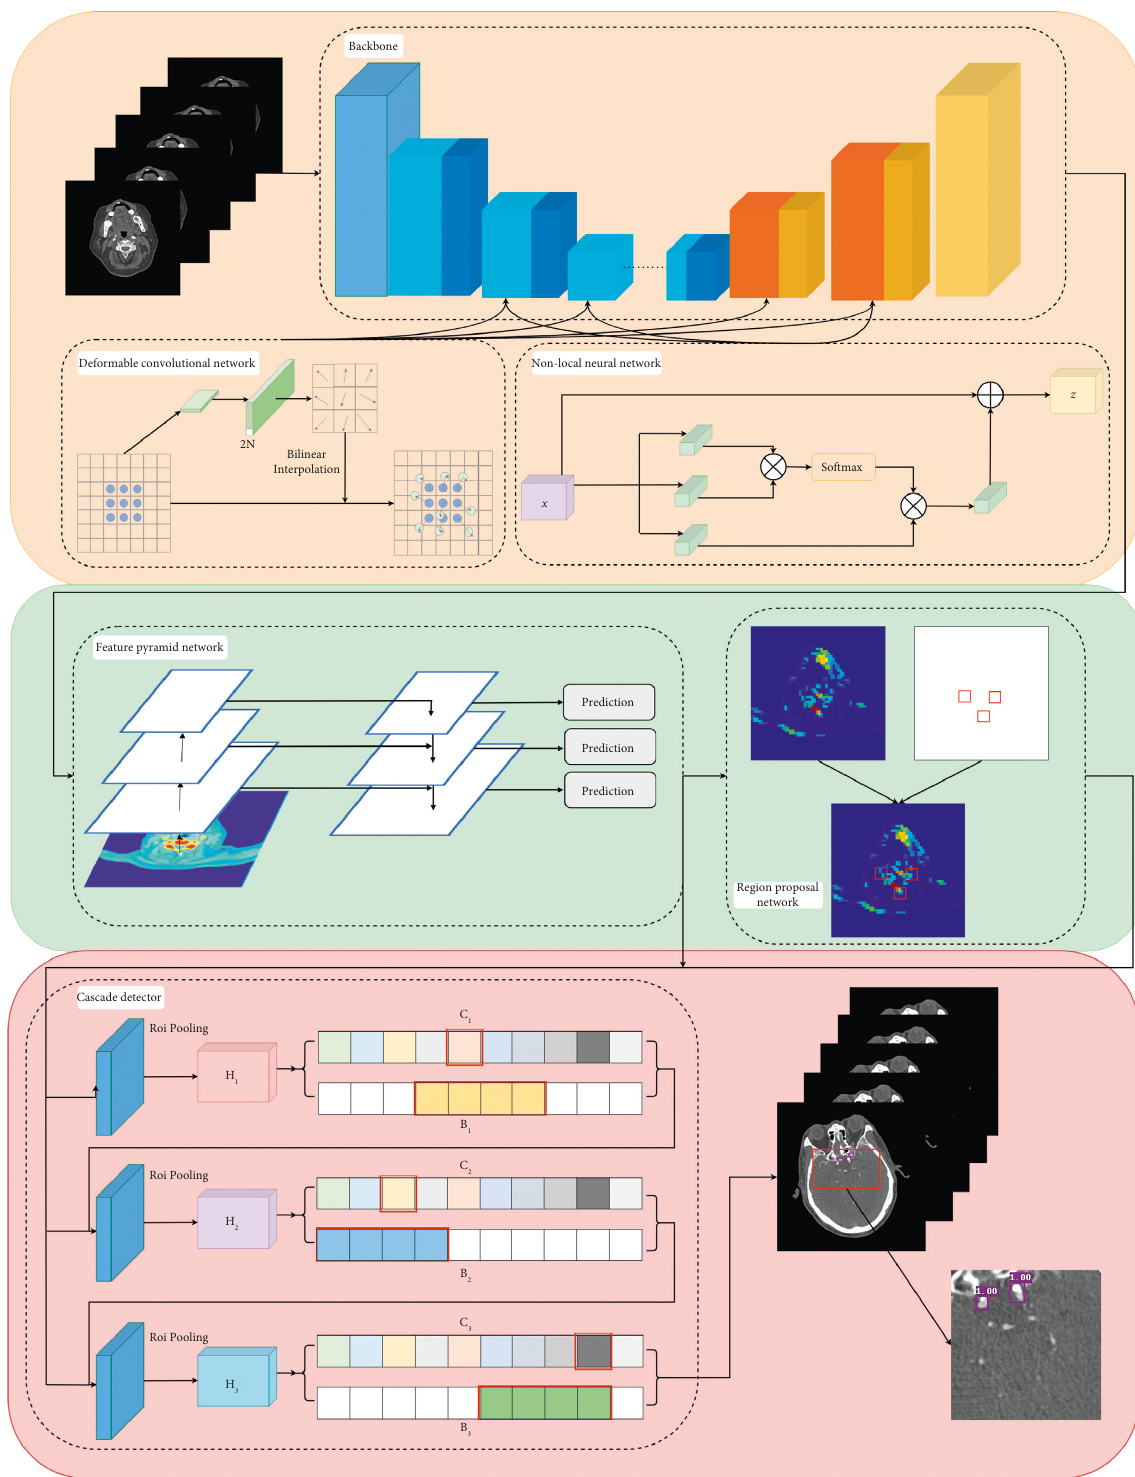
Figure 2: Flowchart of the retrained algorithm in this study. CTA images are fed into the backbone, consisting of Resnet50, deformable convolutional networks, and nonlocal neural networks incorporated in the third, fourth, and fifth stages of Resnet50. Feature maps from feature pyramid network and region proposal network with multiscale and proposal region information are integrated and then input to the cascade detector to refine the classification and regression by increasing the IoU thresholds in